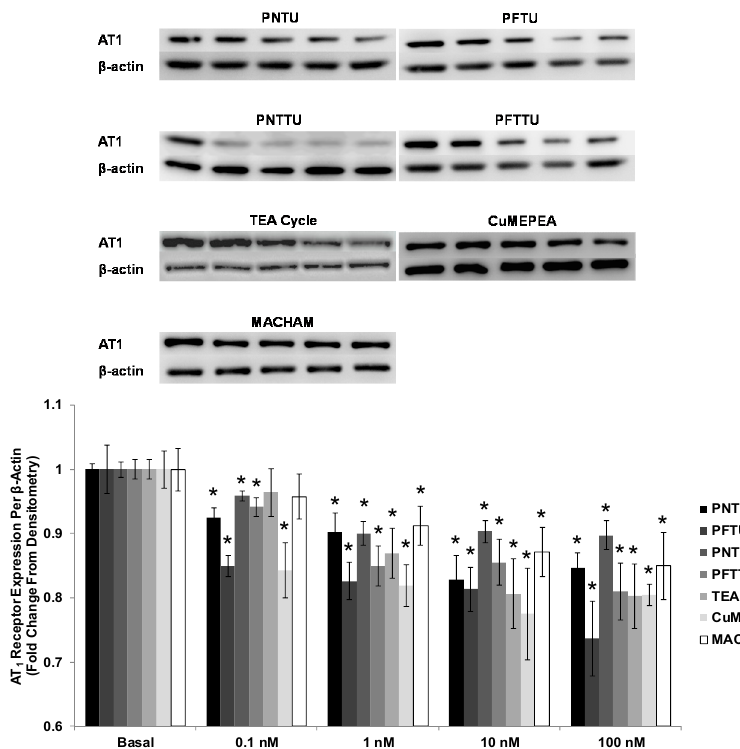
Figure 7. CTB cells were treated with different concentrations of SRs, and Angiotensin II receptor, type 1 (AT 1 ) receptor expression was measured in the cell lysates by Western Blot. The SRs significantly (* p < 0.05) downregulated the expression of AT 1 receptor in CTB cells. The data are presented as mean ± SEM for four experiments. One blot from each of the seven SRs is shown.